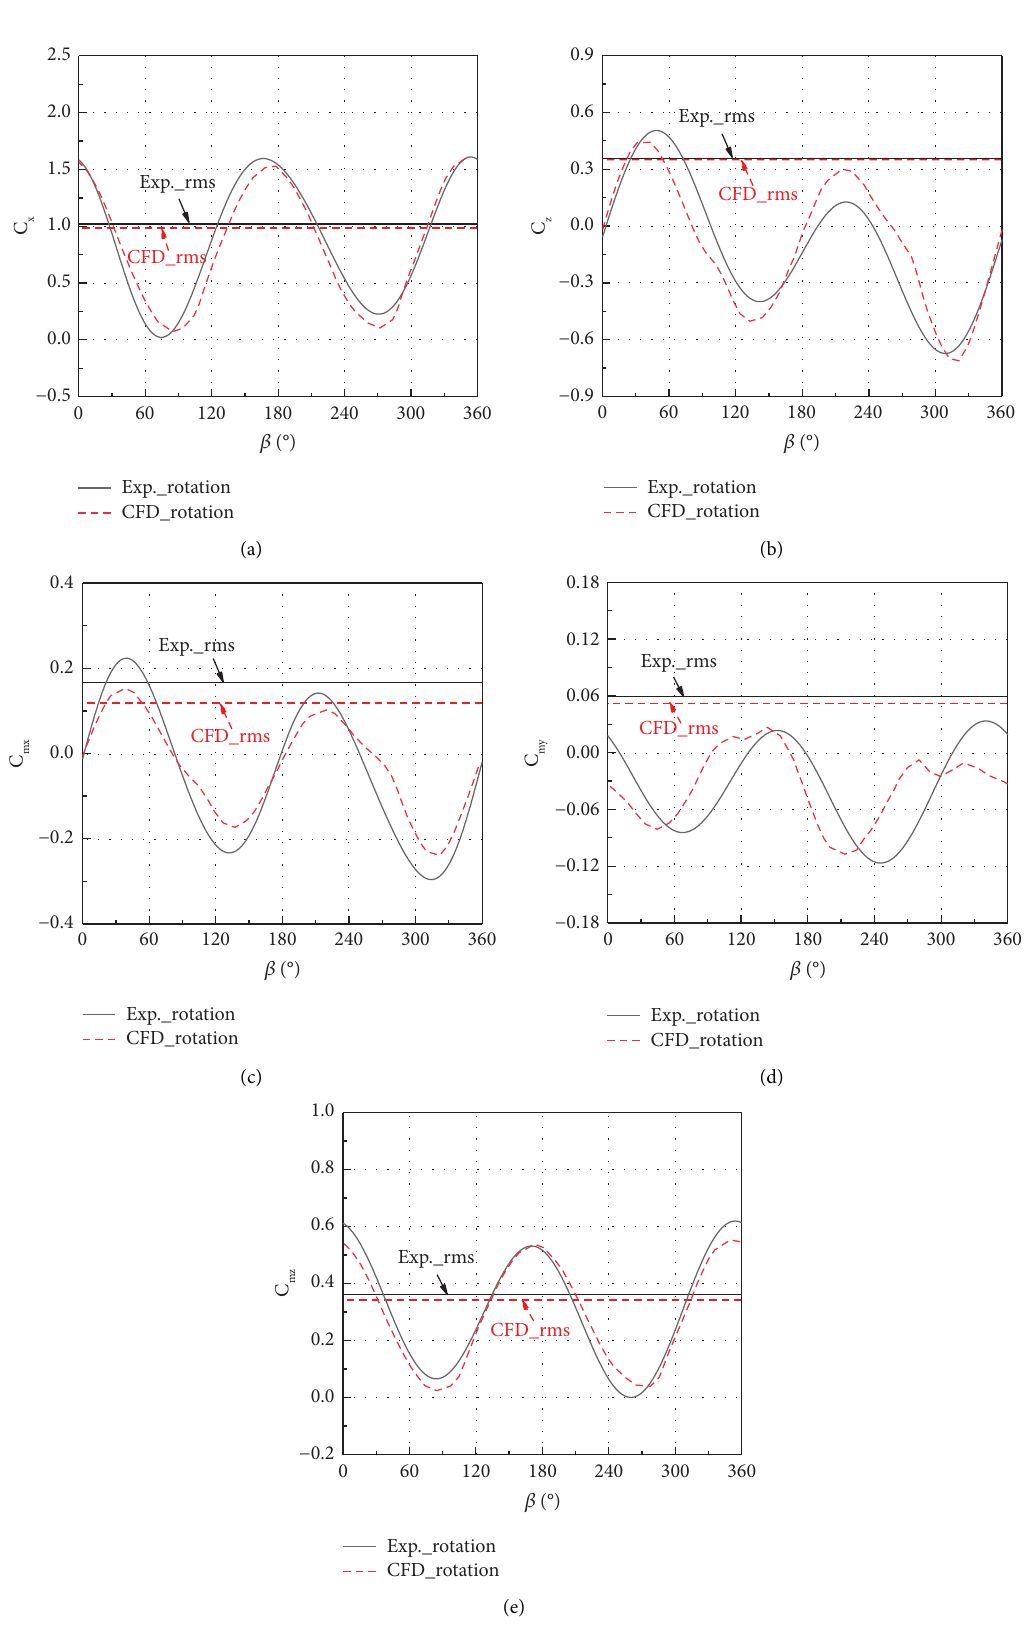
Figure 17: Wind tunnel test results and numerical simulation results of aerodynamic coefficient with respect to azimuth angle when the antenna rotates in azimuth (porous plate, K � 0.34). (a) C x − β , (b) C z − β , (c) C mx − β , (d) C my − β , and (e) C mz − β